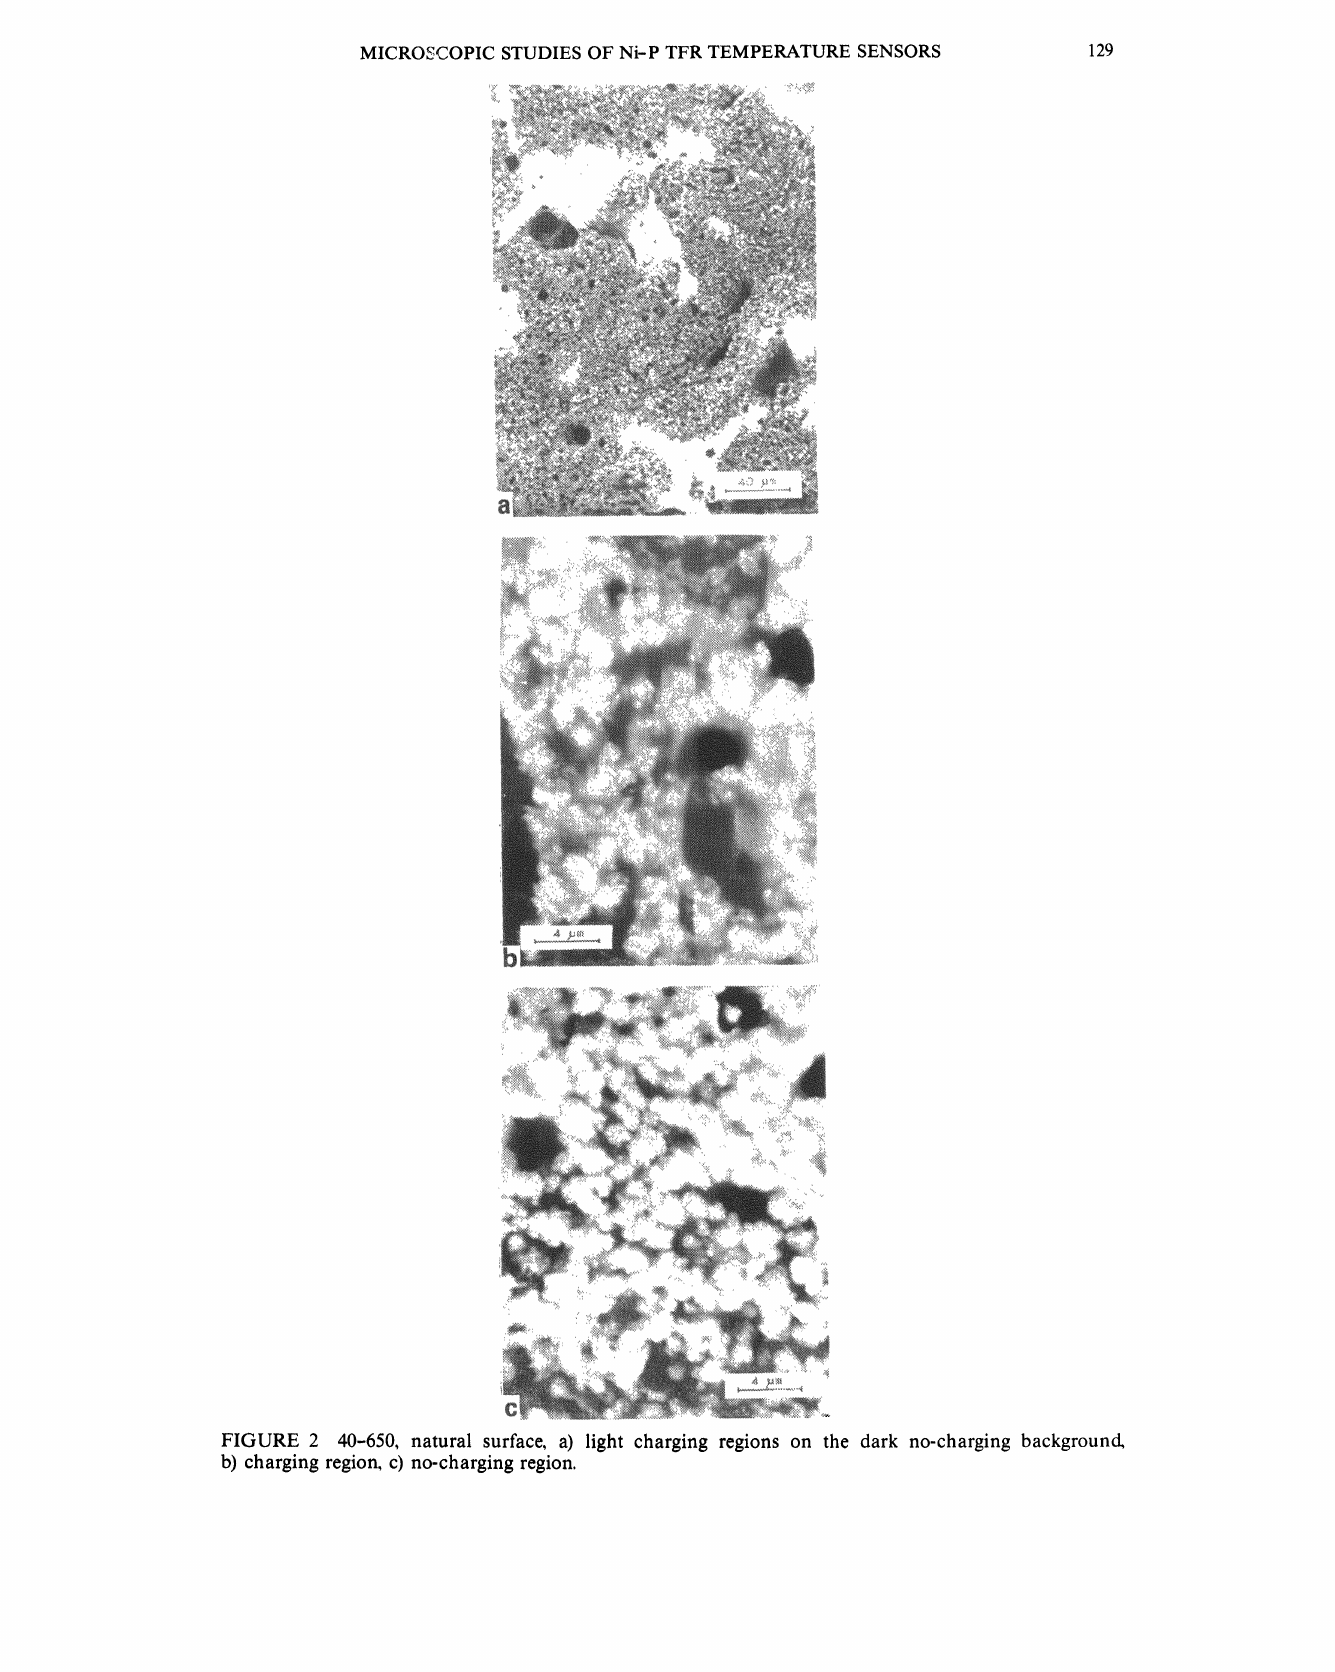
FIGURE 2 40-650, natural surface, a) light charging regions on the dark no-charging background, b) charging region, c) no-charging